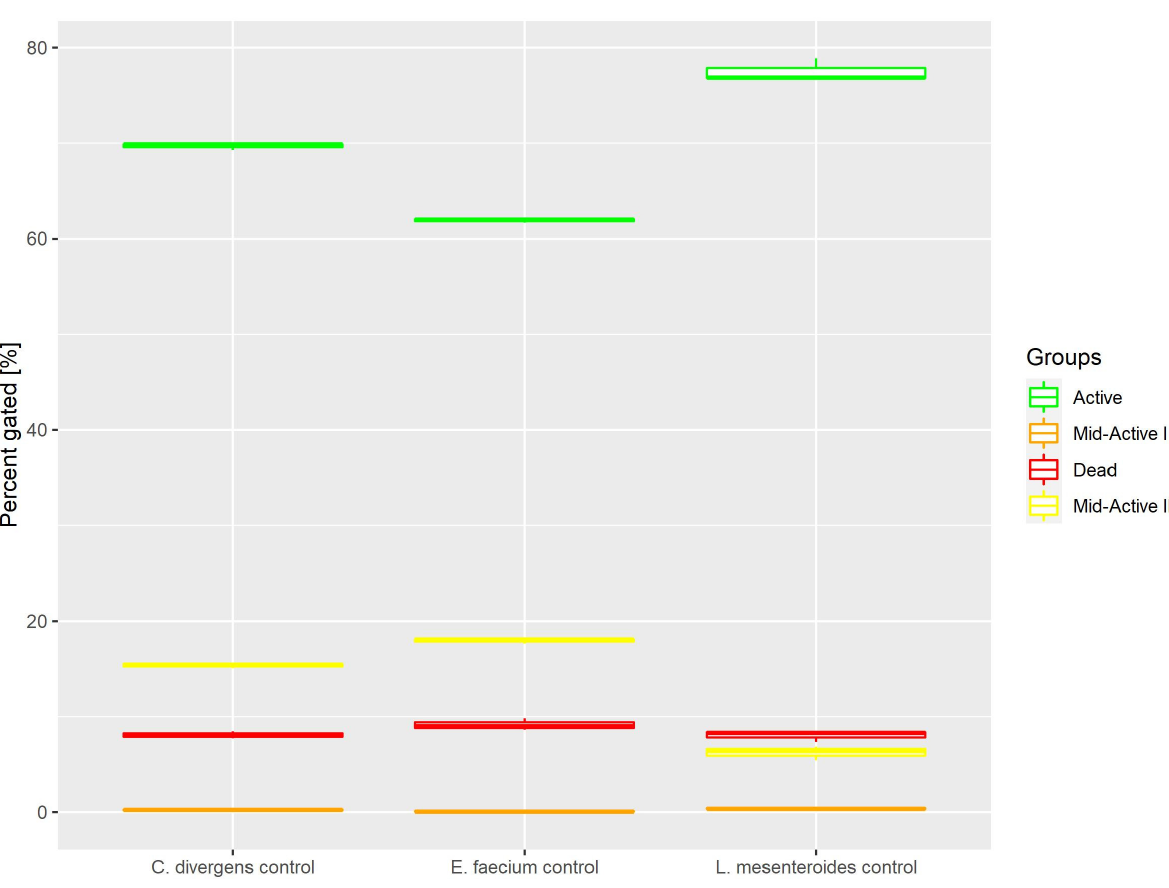
Figure 3. Cell subpopulation percentages in control samples. The distribution of cells between different groups was measured after culturing in optimal conditions.